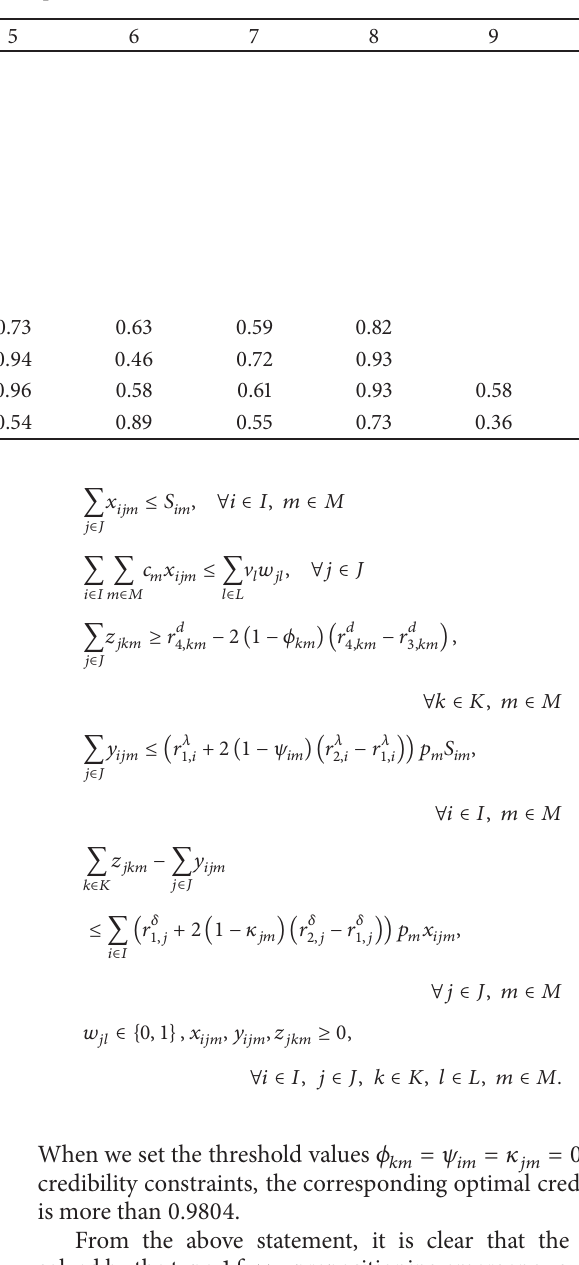
Table 7: Values of parameter 𝜃